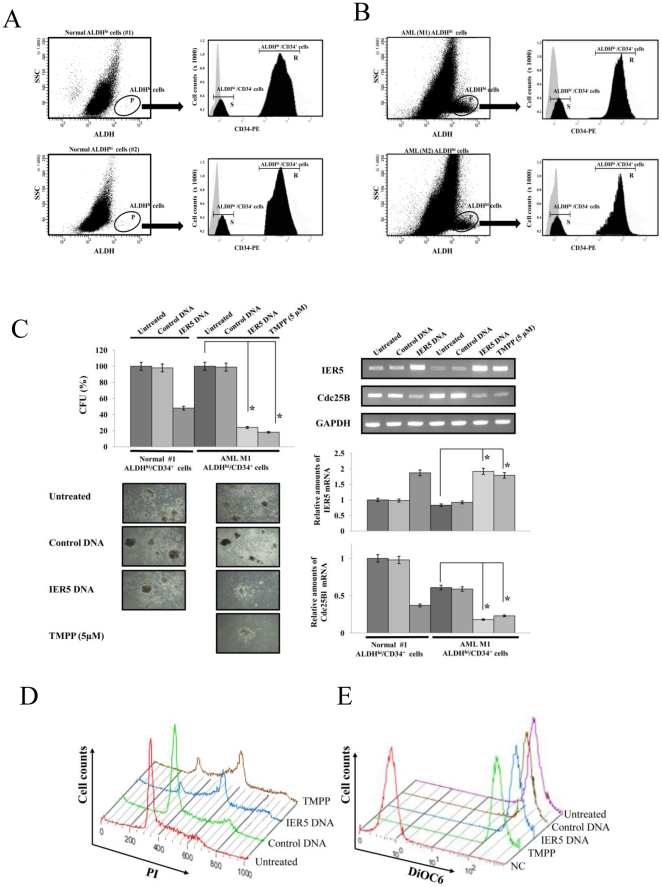
IER5 inhibits the colony formation of ALDHhi/CD34+ cells isolated from AML patients.A. Selection of ALDHhi/CD34+ hematopoietic progenitor cells from the bone marrow of two healthy volunteers (#1 and #2) by FACS sorting. Region P denotes populations of ALDHhi cells. Region R and S denote populations of CD34+ and CD34- cells in the ALDHhi population (Region P), respectively. Negative control, light grey region; CD34-PE staining, dark grey region. B. Selection of ALDHhi/CD34+ hematopoietic progenitor cells from the bone marrow of two AML patients (M1 and M2) by FACS sorting. Region P denotes populations of ALDHhi cells. Region R and S denote populations CD34+ and CD34- cells in the ALDHhi population (Region P), respectively. Negative control, light grey region; CD34-PE staining, dark grey region. C. ALDHhi/CD34+ cells were purified from a healthy volunteer (#1) and an AML patient (M1), and were cultured in semisolid methylcellulose media. The ALDHhi/CD34+ cells from each source were left untransfected or were transfected with IER5 cDNA, or treated with TMPP (5 µM). After 14 days culture, the colony forming ability of the cells was analyzed (left upper panel) and the cells were viewed using phase-contrast microscopy. Original magnification ×4 (left bottom panels). Their mRNA expression of IER5 and Cdc25B was assessed using RT-PCR and quantitative RT-PCR (right panels). Colonies formed by these ALDHhi/CD34+ cells (3×102 to 5×102 cells/plate) were counted following plating in semisolid methylcellulose media. Colony formation was evaluated by determination of colony counts as a percentage of the corresponding control. The results are the means ± SD of three independent experiments. *P<0.01 compared with untreated control cells. RT-PCR results representative of three independent experiments are shown. GAPDH mRNA expression is shown as an internal control. The ALDHhi/CD34+ cells whose IER5 mRNA expression was analyzed by quantitative RT-PCR were derived from an AML patient (M1). The levels of the quantified RT-PCR products were normalized to GAPDH expression in the same sample and were then expressed relative to the mRNA level of a normal control which was assigned a value of 1. D and E. Cell cycle analysis (D) and changes of mitochondrial membrane potential (ΔΨm) (E) in IER5 overexpressed or TMPP treated AML-derived ALDHhi/CD34+ cells. ALDHhi/CD34+ cells were purified from an AML patient (M1), and were then transfected with IER5 cDNA or were treated with TMPP (5 µM). The IER5-transfected or TMPP-treated cells were harvested after 3 days. The cell cycle distribution and the ΔΨm of the ALDHhi/CD34+ cells was analyzed using flow cytometric analysis. The FACS results are representative of three independent experiments. NC; Negative control.